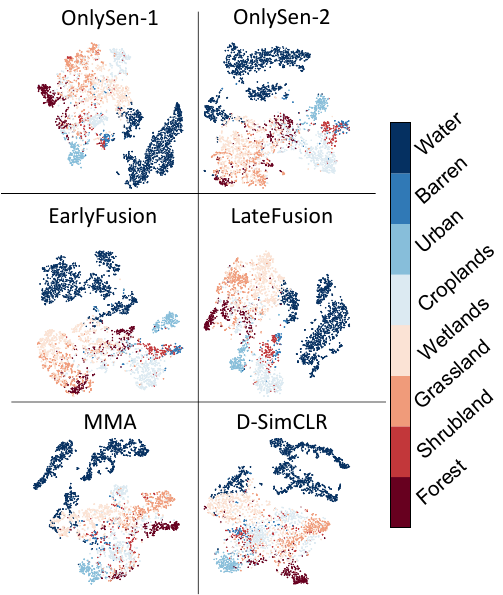
Figure 5. Visualization of the latent space of supervised baseline methods (top uni-modal, middle data fusion) and self-supervised methods (bottom), generated with t-SNE. Samples are colored by land-cover